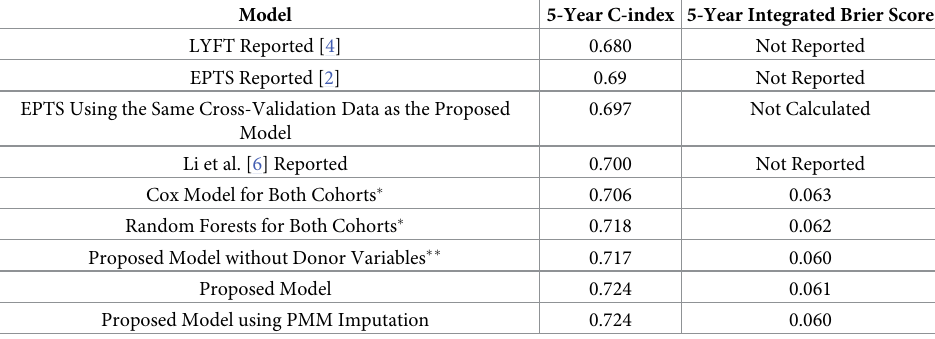
Table 2. Performance of the proposed predictive model compared to other